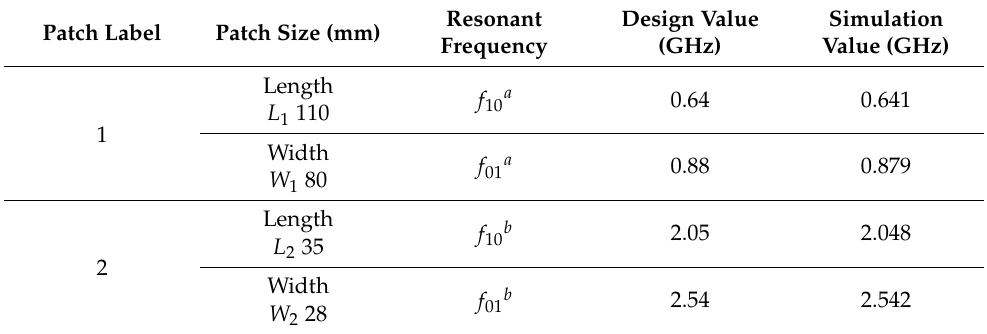
Table 1. Design parameters of multilayer patch antenna sensor. Patch Label